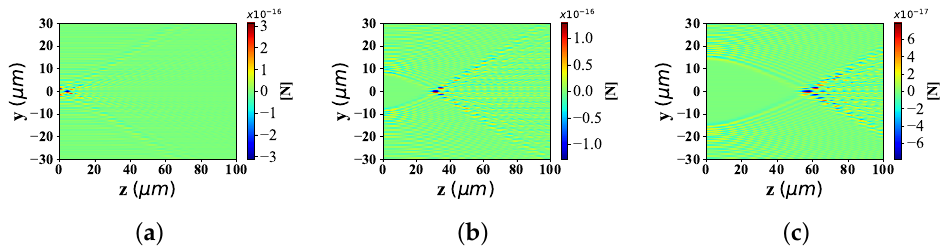
Figure 8. Distribution of F y under the interaction between the sphere and Bessel pincer light-sheets beam with different beam order l ( l = 5, 45, 85; α 0 = 0.5; radius is 0.1 µ m). ( a ) ł = 5; ( b ) ł = 45; ( c ) ł = 85.